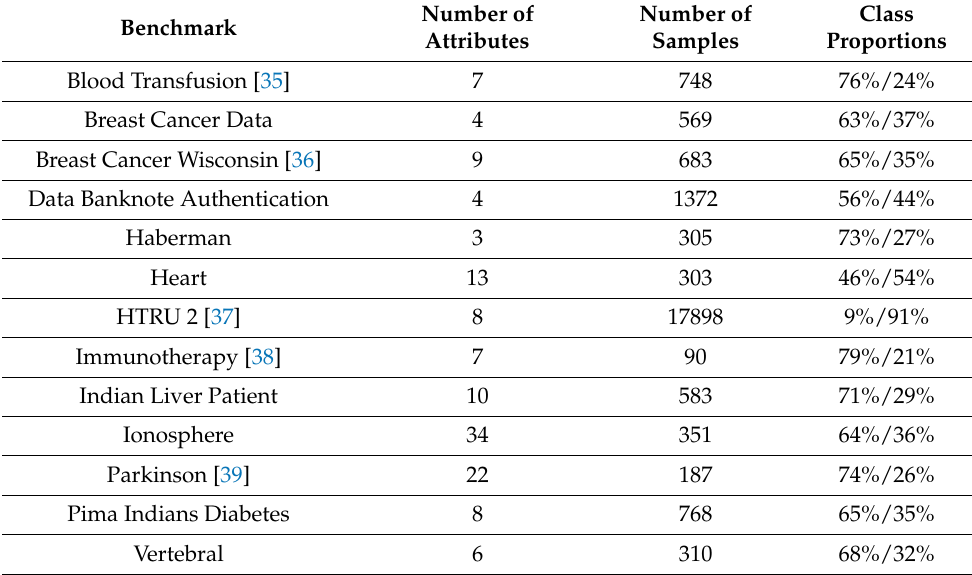
Table 1. The data sets